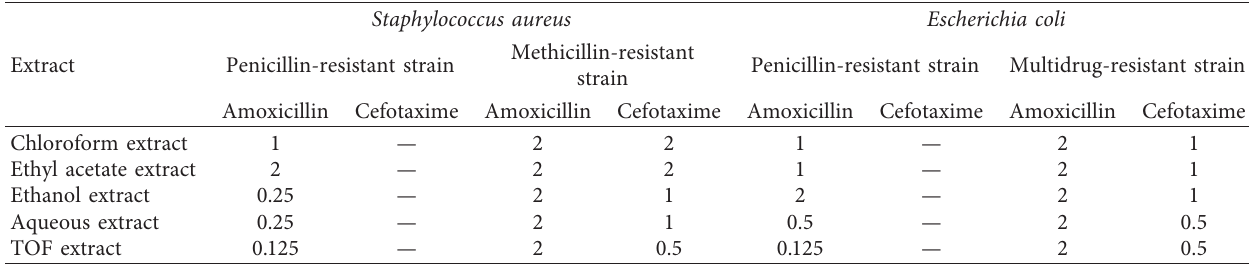
Table 4: Antibiotic modulation activity of P. granatum leaf extracts by checkerboard method (FIC index).